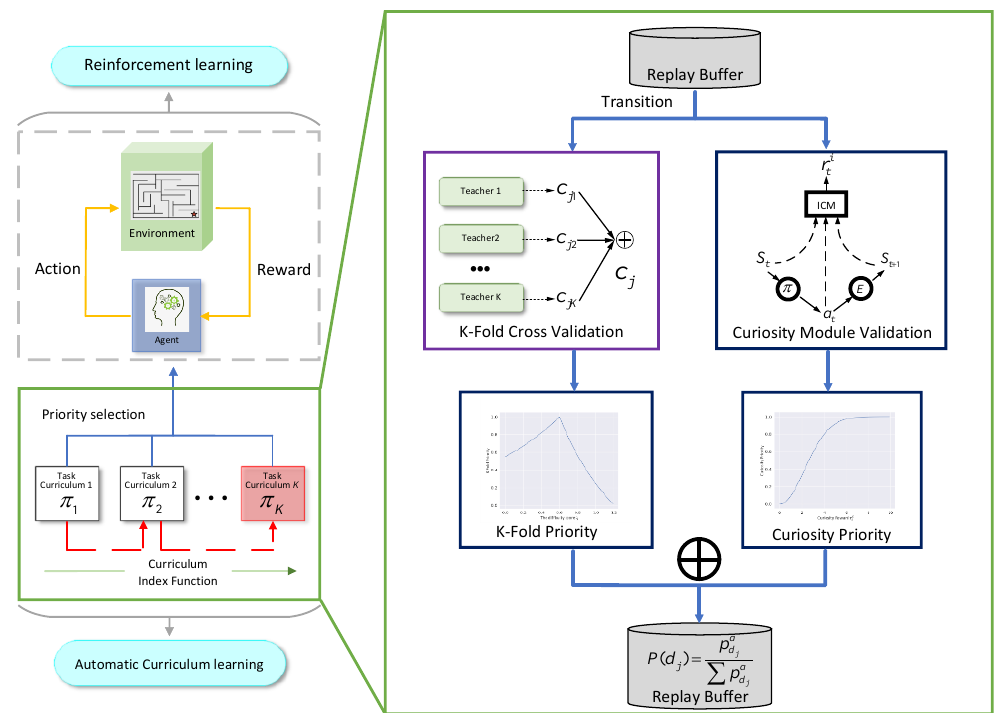
Figure 6. Framework diagram of curriculum reinforcement learning algorithm based on curiosity module.